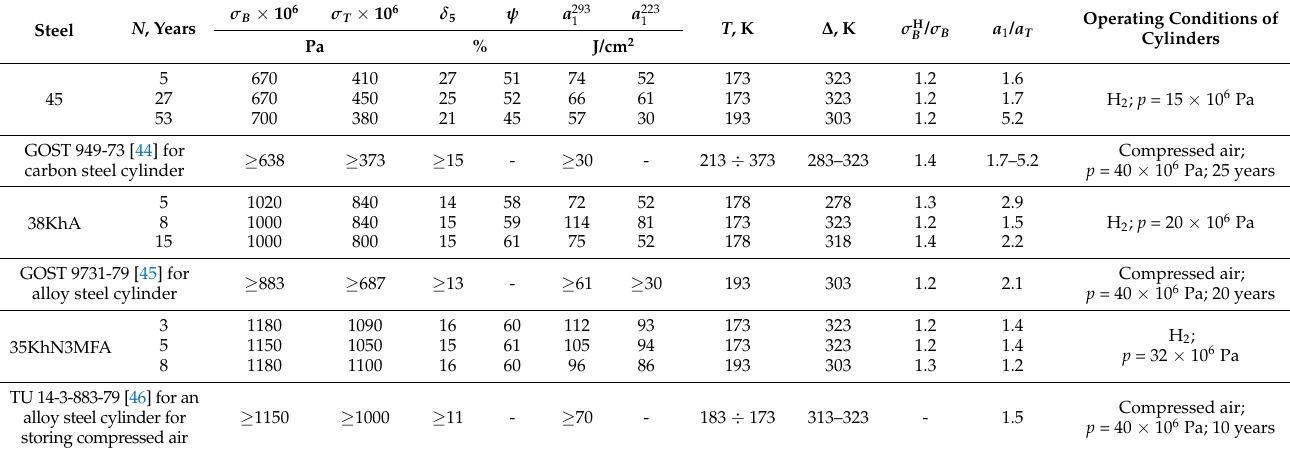
Table 3. Mechanical properties of cylinder materials after prolonged contact with high-pressure hydrogen